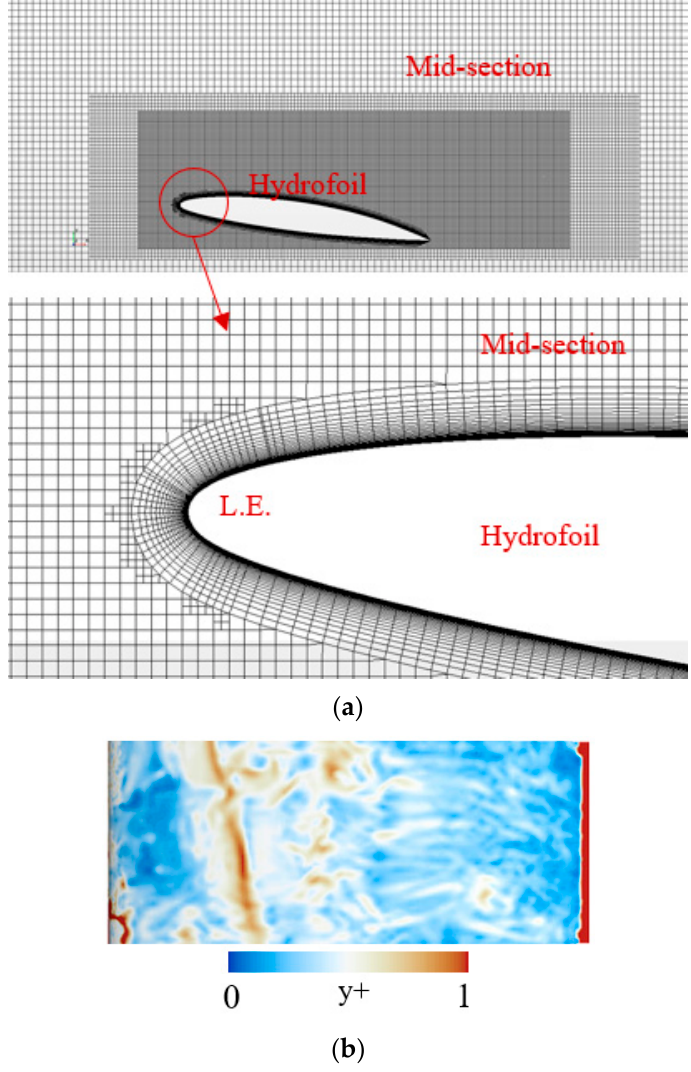
Figure 2. Mesh generation and y+ at t = 0.566 s around the hydrofoil. ( a ) Mesh generation at Mid-section and a visualization close to the profile, ( b ) y+ at t = 0.566 s. Three pressure-monitoring points were set on the mid-section of the hydrofoil, as shown in Figure 3.